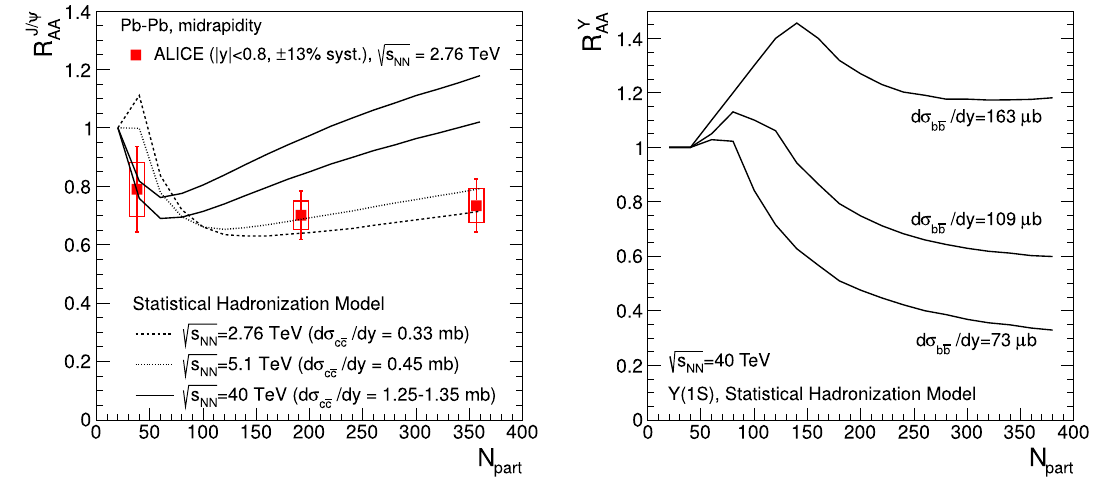
Fig. 16.5 Nuclear modification factor R AA of J / ψ (left) and ϒ( 1 S ) mesons (right) at LHC and FCC energies as a function of the collision centrality (number of participant nucleons)